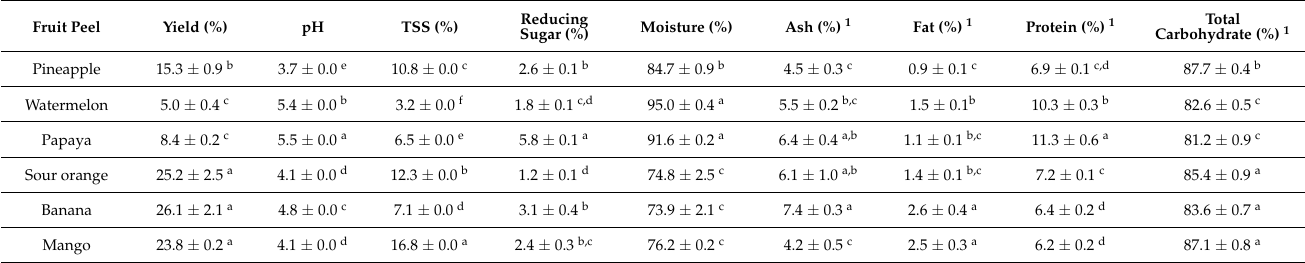
Table 1. Physicochemical properties of pineapple, watermelon, papaya, mango, sour orange, and banana